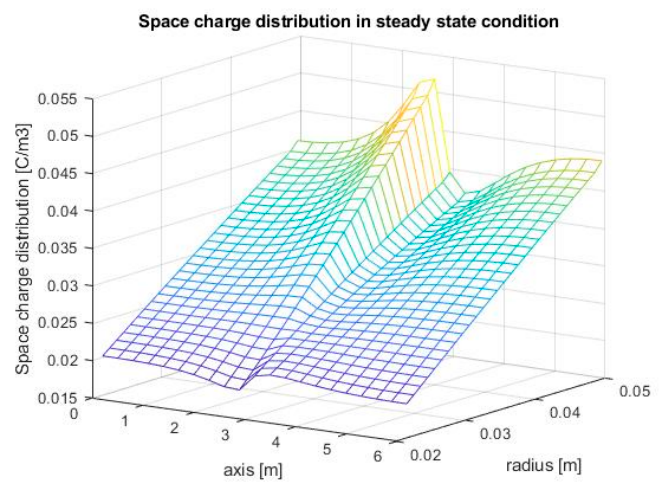
Figure 6. Space charge vs. radius and axis in steady state conditions—Scenario E.